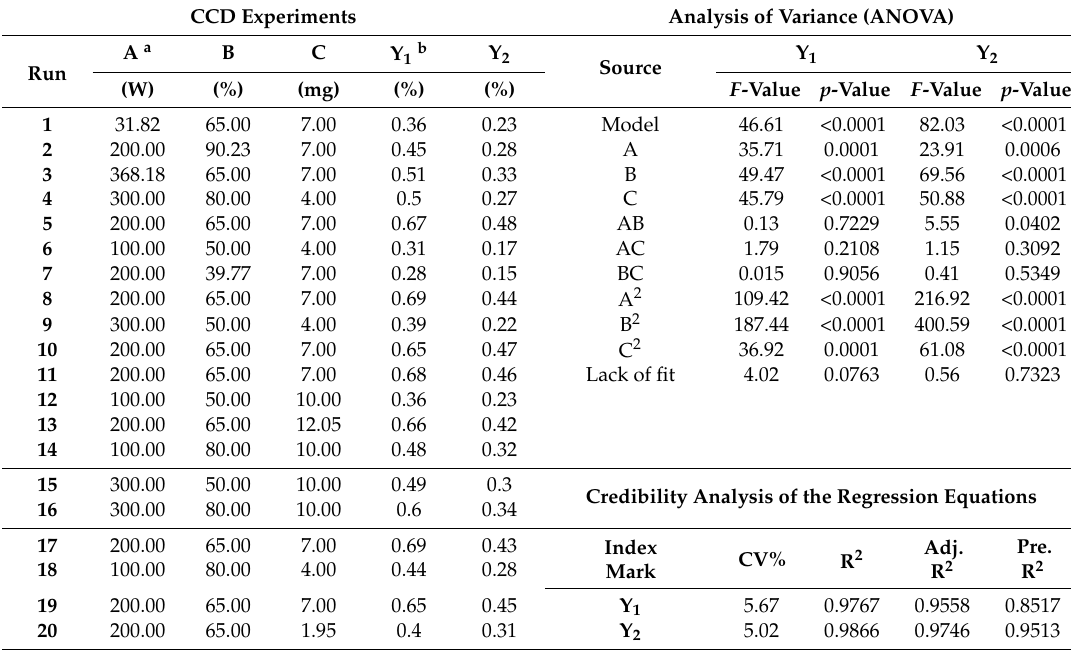
Table 4. Rotatable central composite design (RCCD) with experimental values for the yields of total flavonoids and ginkgolides from Ginkgo biloba fallen leaves, analysis of variance (ANOVA) for response surface quadratic model, and fit statistics for the response values ( n =